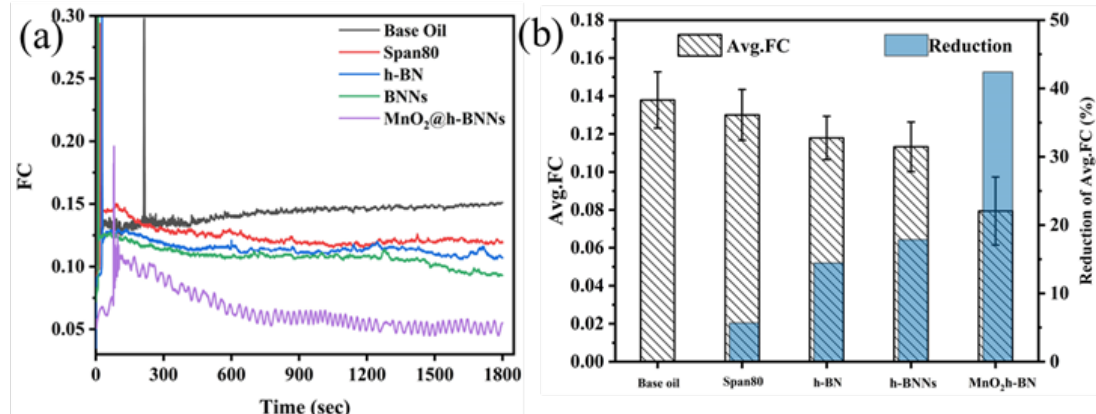
Figure 4. FC curves ( a ) and Avg. FC ( b ) of oil samples with different compositions.